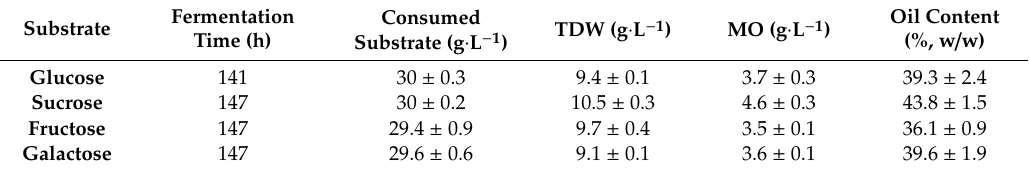
Table 2. Consumption of substrate, along with the production of total dry weight (TDW), microbial oil (MO), and intra-cellular oil content during the cultivation of R. toruloides using commercial glucose, sucrose, fructose, and galactose at 30 g · L − 1